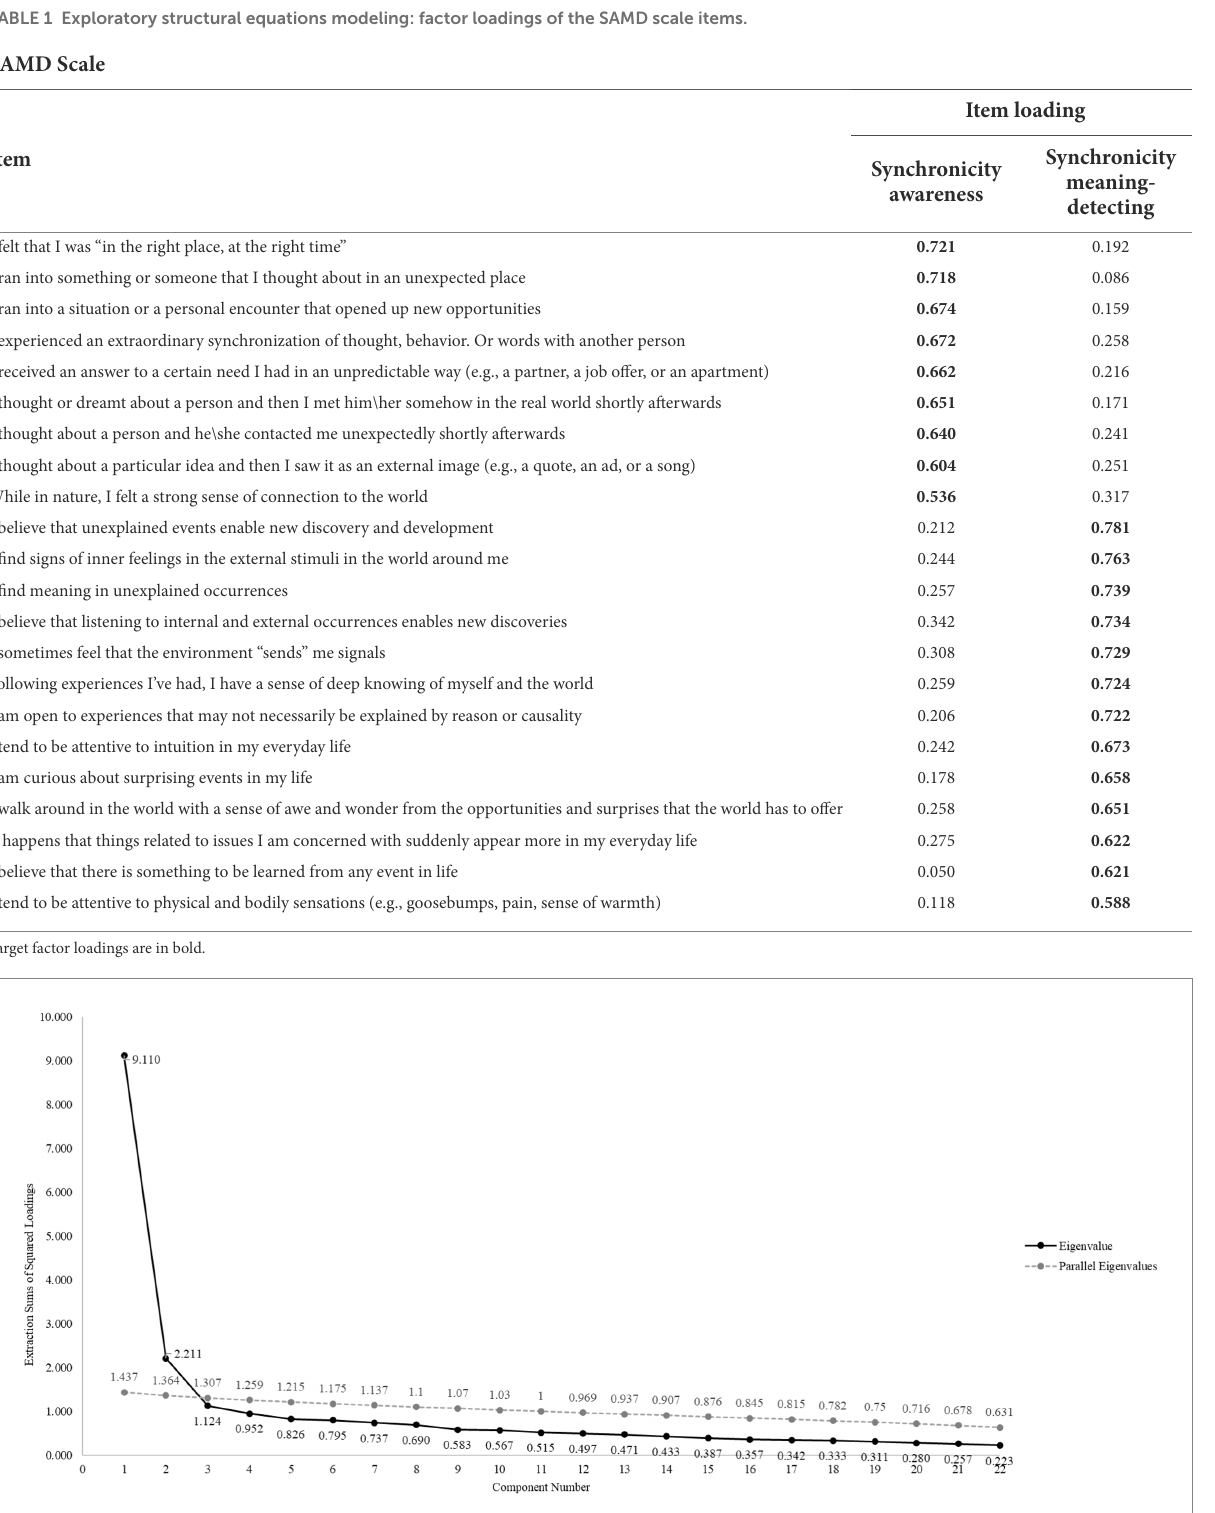
TABLE 1 Exploratory structural equations modeling: factor loadings of the SAMD scale items.